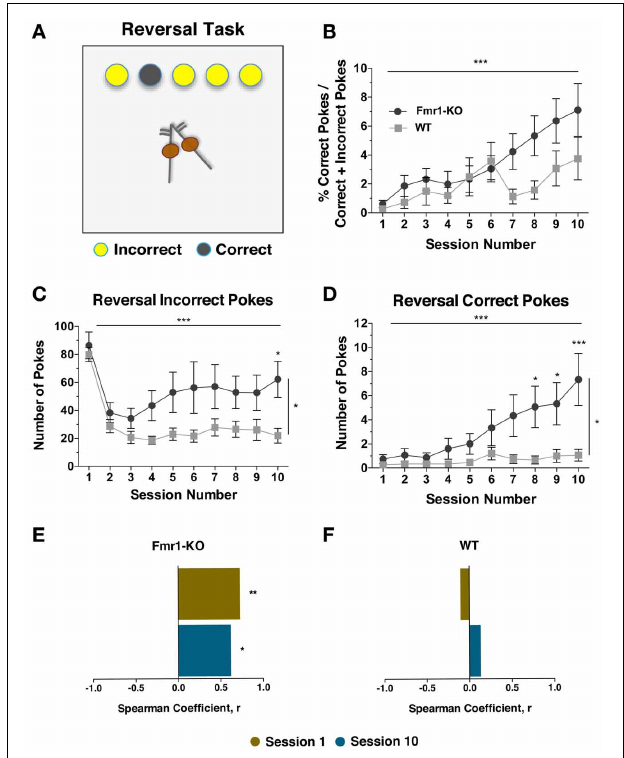
FIGURE 7 | Fmr1 -KO mice demonstrate enhanced responding upon rule reversal in the 5CSRTT. During the reversal task a correct trial is now a response in the non-illuminated hole and a response in any of the illuminated holes is deemed incorrect but without consequences (A) . After 10 sessions the percentage of correct responses compared to the total responses was not significantly different (B) . Both groups of mice performed significantly less incorrect pokes, but Fmr1 -KO made more incorrect pokes compared to WT mice (C) . The number of correct pokes increased significantly for both groups after 10 sessions, with Fmr1 -KO mice performing more correct responses than WT by the last session (D) . Incorrect pokes during L2 correlated with the reversal correct trials for individual Fmr1 -KO mice during sessions 1 and 10 (E) . No such correlation existed for WT mice (F) . Values plotted represent means ± SEM. For panels (B) , (C) , and (D) analysis was performed with a 2-way repeated measures ANOVA with Bonferroni’s post-test analysis. For all panels asterisks indicate significance levels; ∗∗∗ p < 0 . 001, ∗∗ p < 0 . 01, ∗ p < 0 .